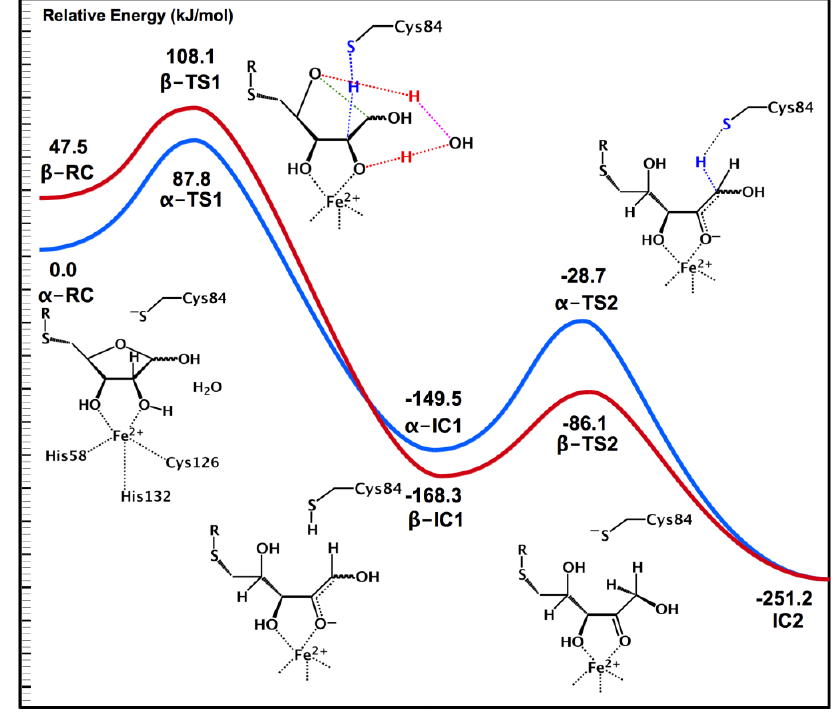
Figure 2. Potential energy profile for conversion of for α - and β -SRH into a 2-keto-SRH intermediate via a water-mediated ring opening process. The blue/red potential energy surface corresponds to the α / β -SRH conversion, respectively. The colored lines in the transition state schematic structures correspond to the particular bonds being broken and